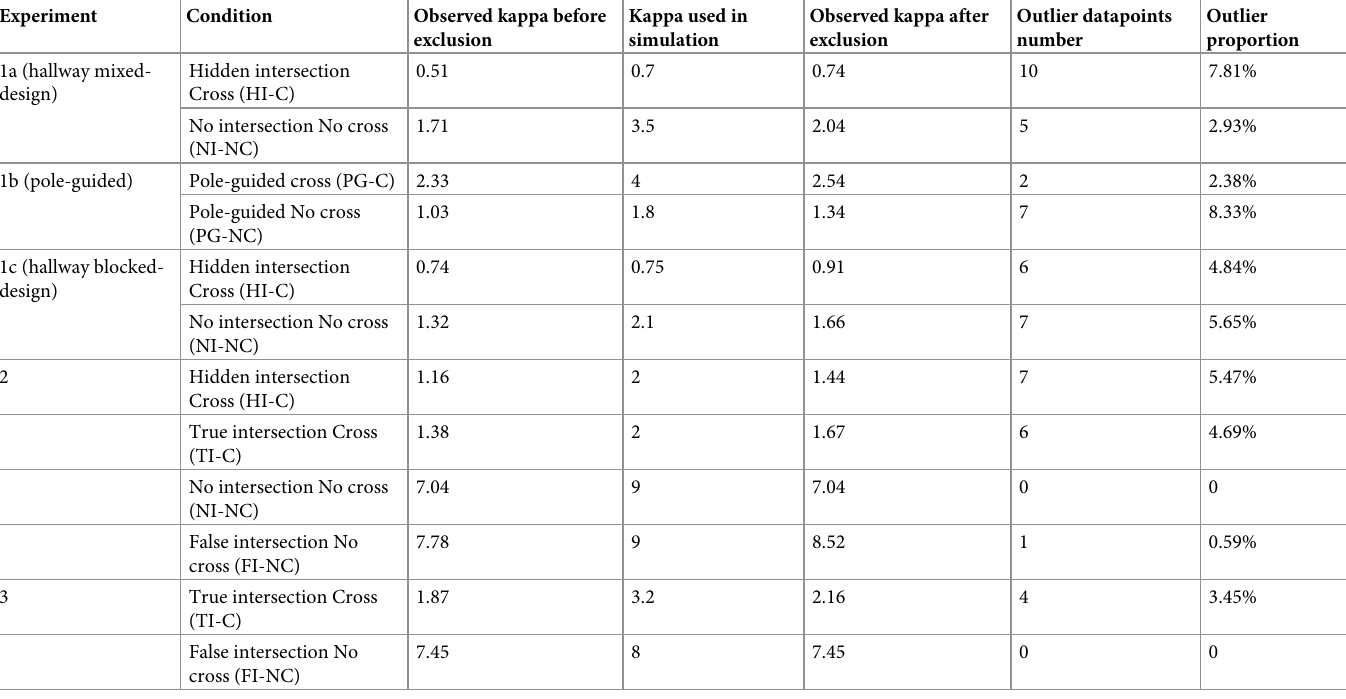
Table 2. Outlier proportions and kappa values in outlier detection procedure in Experiments